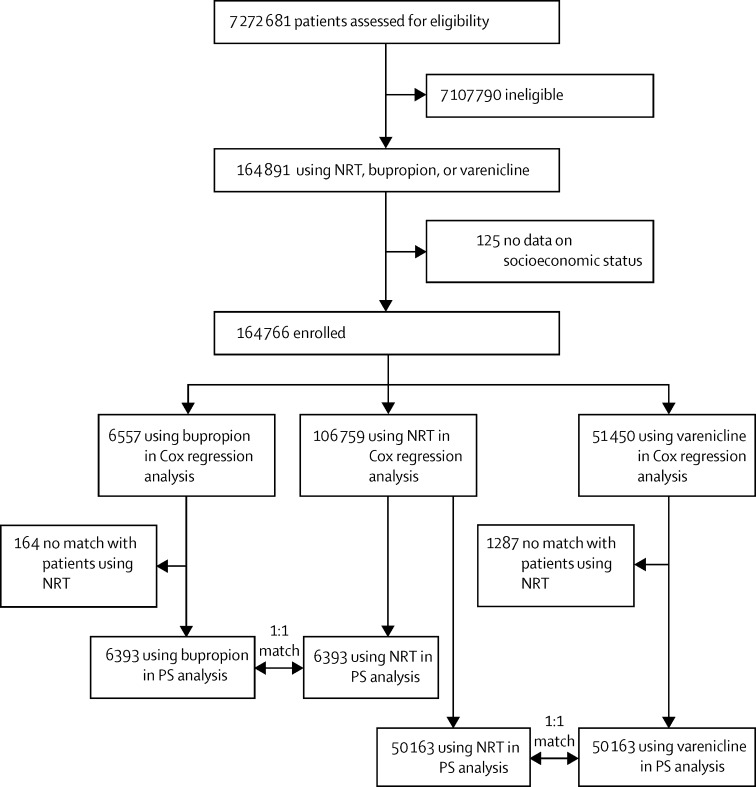
Flow chartNRT=nicotine replacement treatment. PS=propensity score.